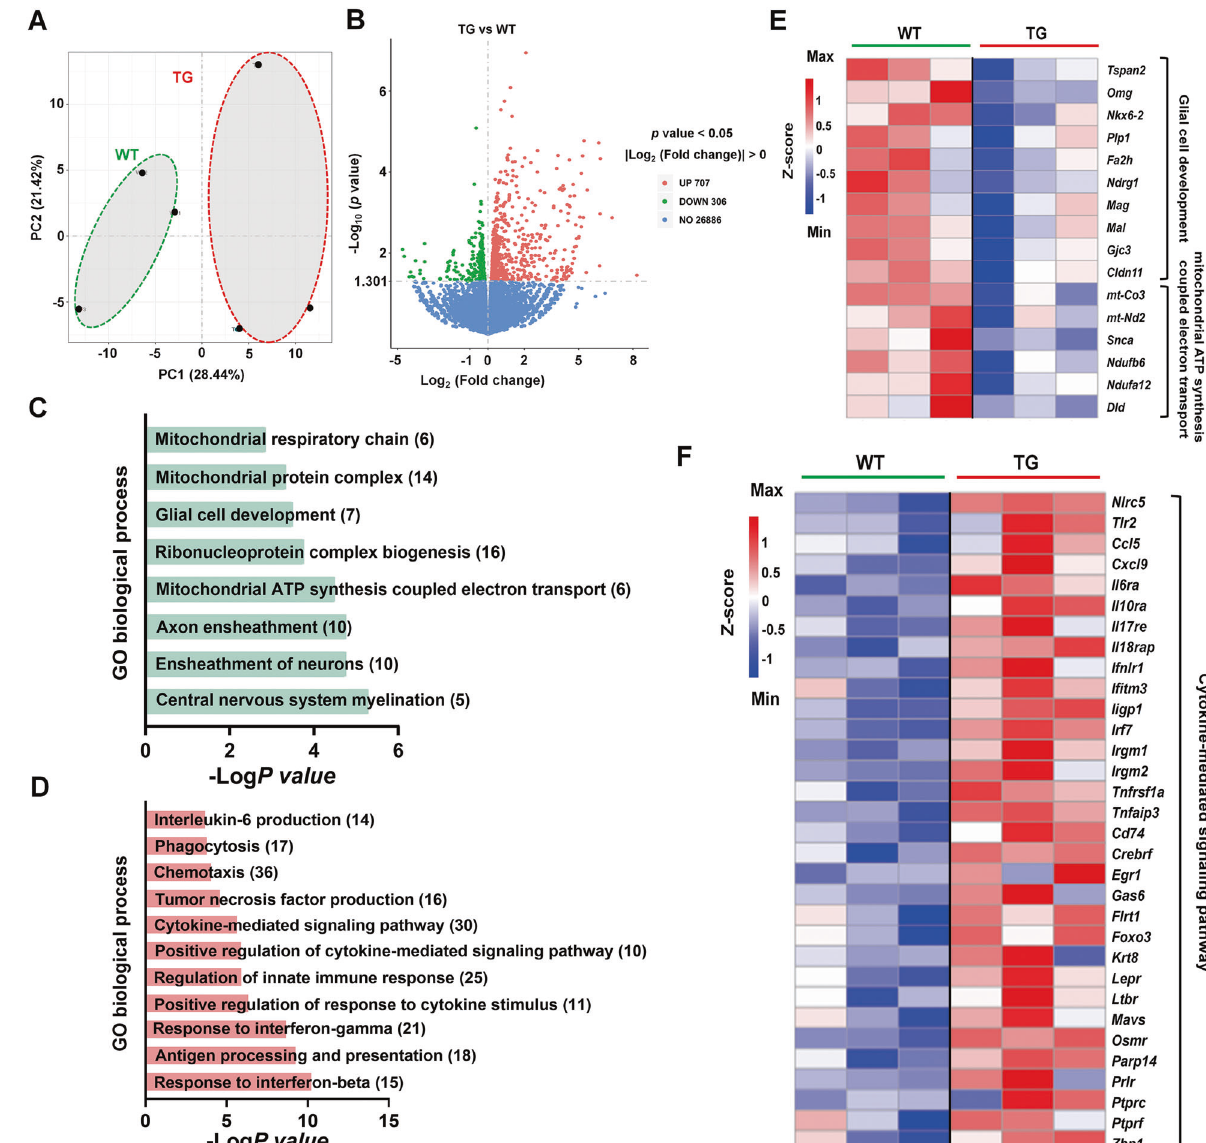
Fig. 7 Transcriptome analysis of G82R/L85P variant knock-in mice. A PCA score plots revealed a distinct separation between components in WT and TG mice. B DEGs between WT and TG mice are shown in a volcano plot. C , D The representative GO pathways enriched by down- and up-regulated DEGs between WT and TG mice are shown. E Downregulated DEGs enriched in “ Glial cell development ” and “ Mitochondrial ATP synthesis coupled electron transport ” pathways are shown. F Upregulated DEGs enriched in the “ Cytokine-mediated signaling pathway ” are